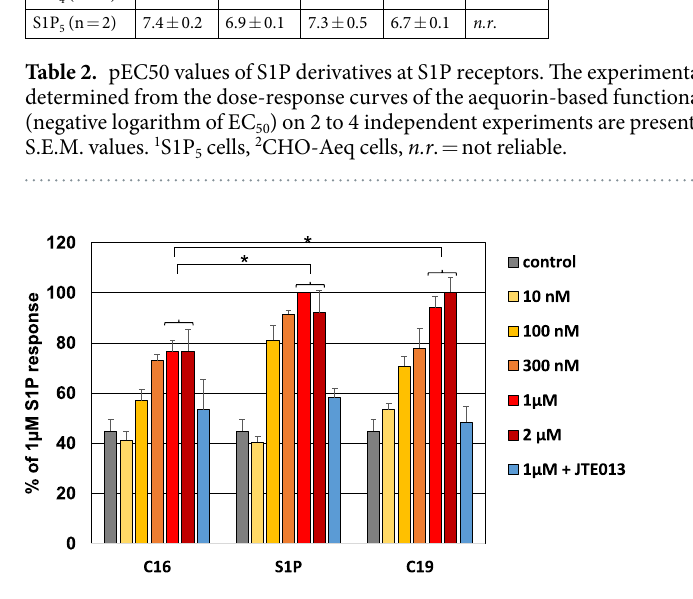
Figure 4. NF- κ B activation via S1P 2 in response to S1P analogs. Human BEAS-2B cells naturally expressing